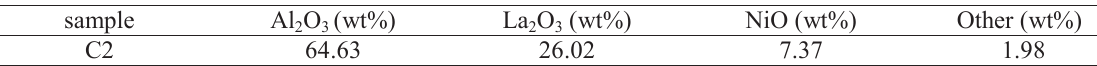
Composition of C2 catalyst (resulted from XRF technique).